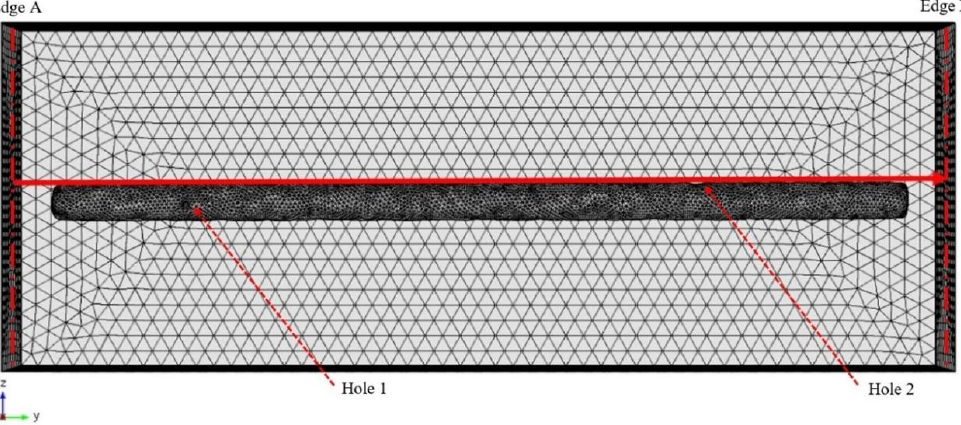
Figure 5. Path of the data recording (at the surface of the rebar in the Y direction).